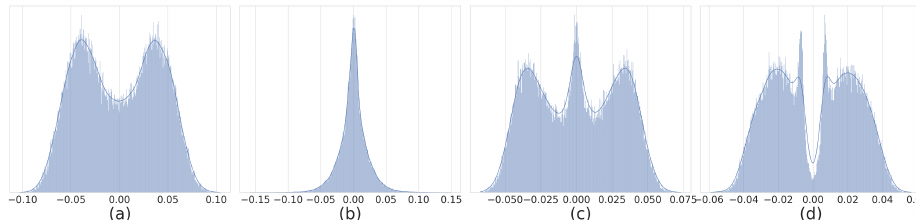
Figure 8. Distribution shifts throughout BD-BNN training. The displayed weights are of the first convolution layer on the second block of ResNet-18 trained on CIFAR-10. ( a ) is the teacher network, ( b ) regular BNN, ( c ) BNN with our weight regularization and ( d ) WDM applied with teacher– student